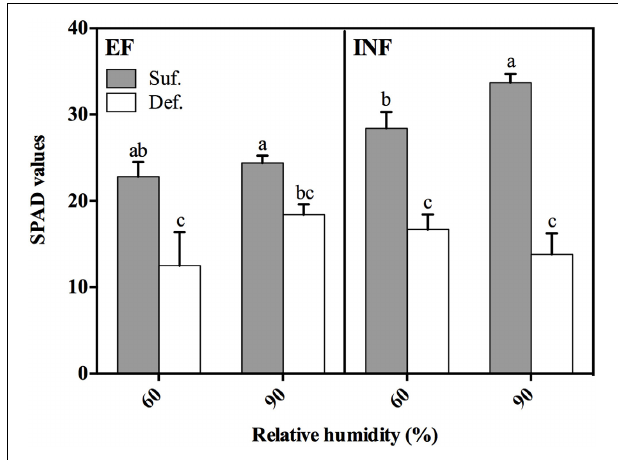
FIGURE 1 | SPAD values measured at 14 days after transferal to hydroponic conditions in “Fe-efficient” (EF, PI 360952) and “Fe-inefficient” (INF, PI 407707) accessions and grown at 60% and 90% relative humidity (RH) under Fe-sufficient (SUF) and Fe-deficient (DEF) conditions. Data are Means ± SEM. Different letters indicate significant differences ( P < 0 . 05) between treatments.